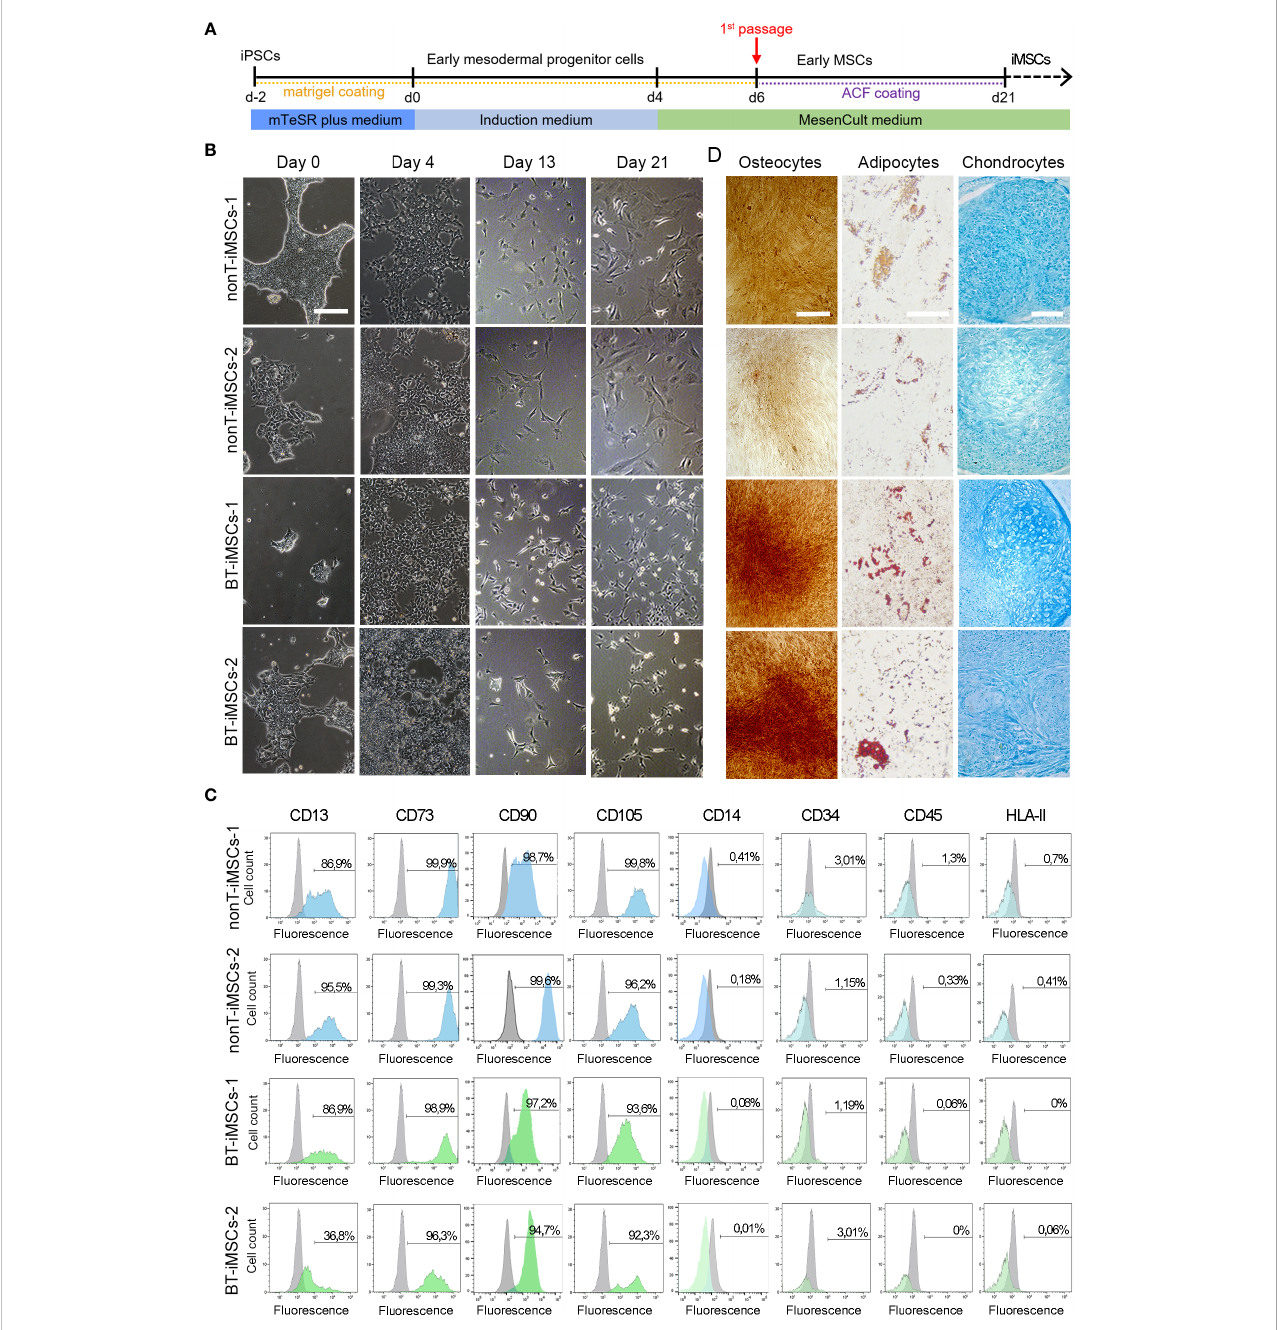
FIGURE 6 Directed differentiation of iPSCs towards iMSCs. (A) Schematic timeline of the process for differentiation into iMSCs. (B) Microscope images showing the morphological aspect of differentiated iMSCs over time (scale bar 100 µm). (C) Flow cytometry analysis of differentiated iMSCs showing that cells were positive for the MSC-speci fi c markers CD13, CD73, CD90 and CD105, whereas they were negative for CD14, CD34, CD45, and HLA-II. (D) Representative images of the differentiated iMSCs into osteocytes (scale bar 100µm), adipocytes (scale bar 50µm) and chondrocytes (scale bar 100µm) identi fi ed by Alizarin Red, Oil Red O and Alcian Blue staining,